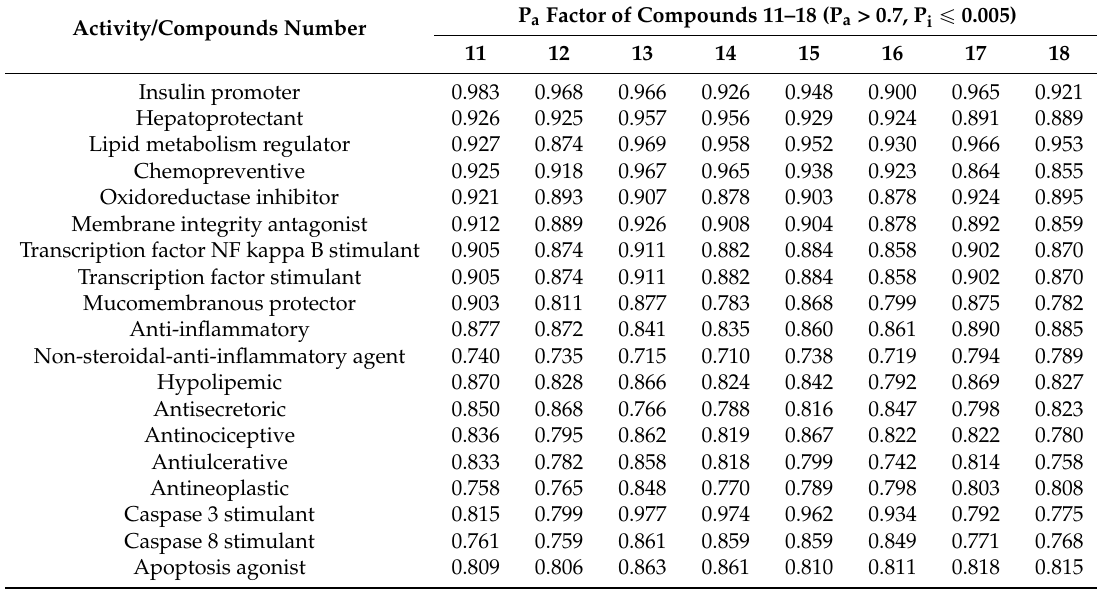
Table 1. Predicted activity of ester-type derivatives 11 – 18 determined by the PASS method. Activity/Compounds